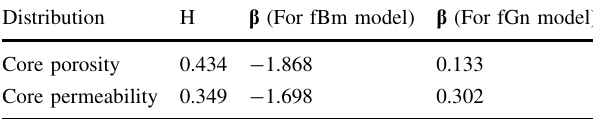
Table 8 Estimation of H, b for core data